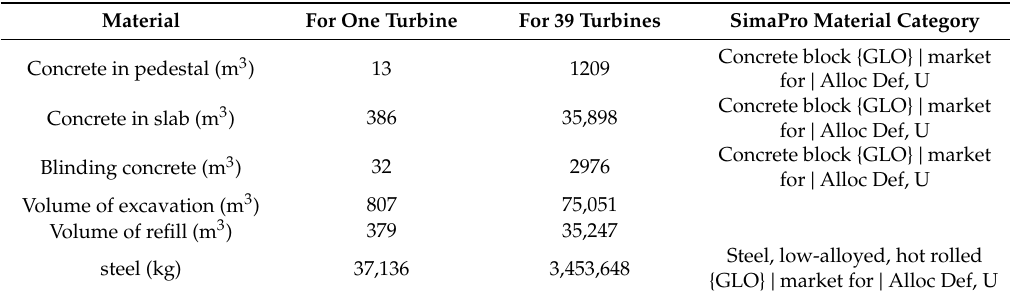
Table 3. Foundation components of V112 Turbines.